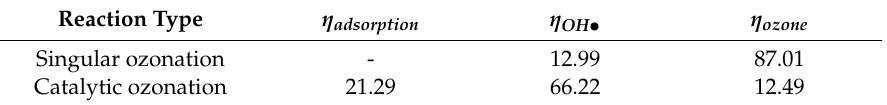
Table 5. Contribution of oxidation type and adsorption to HA degradation.